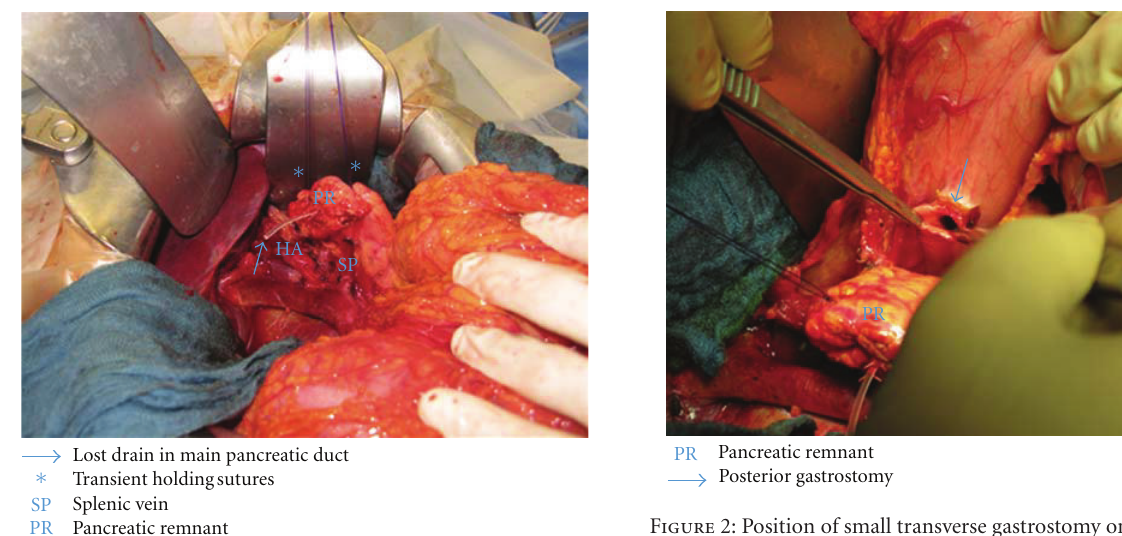
Figure 2: Position of small transverse gastrostomy on the posterior gastric